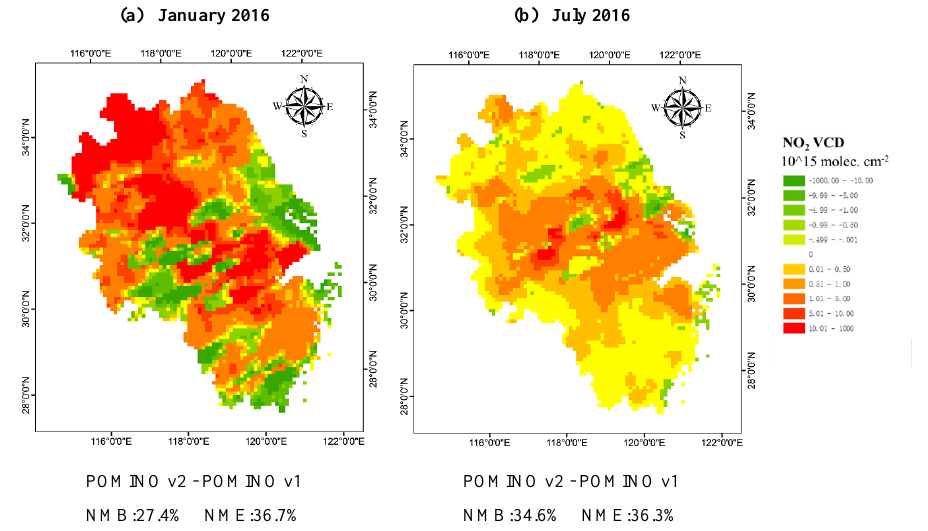
Figure 2. The differences (POMINO v2 - POMINO v1) of NO 2 VCD derived from POMINO v2 and POMINO v1 in January and July 2016.